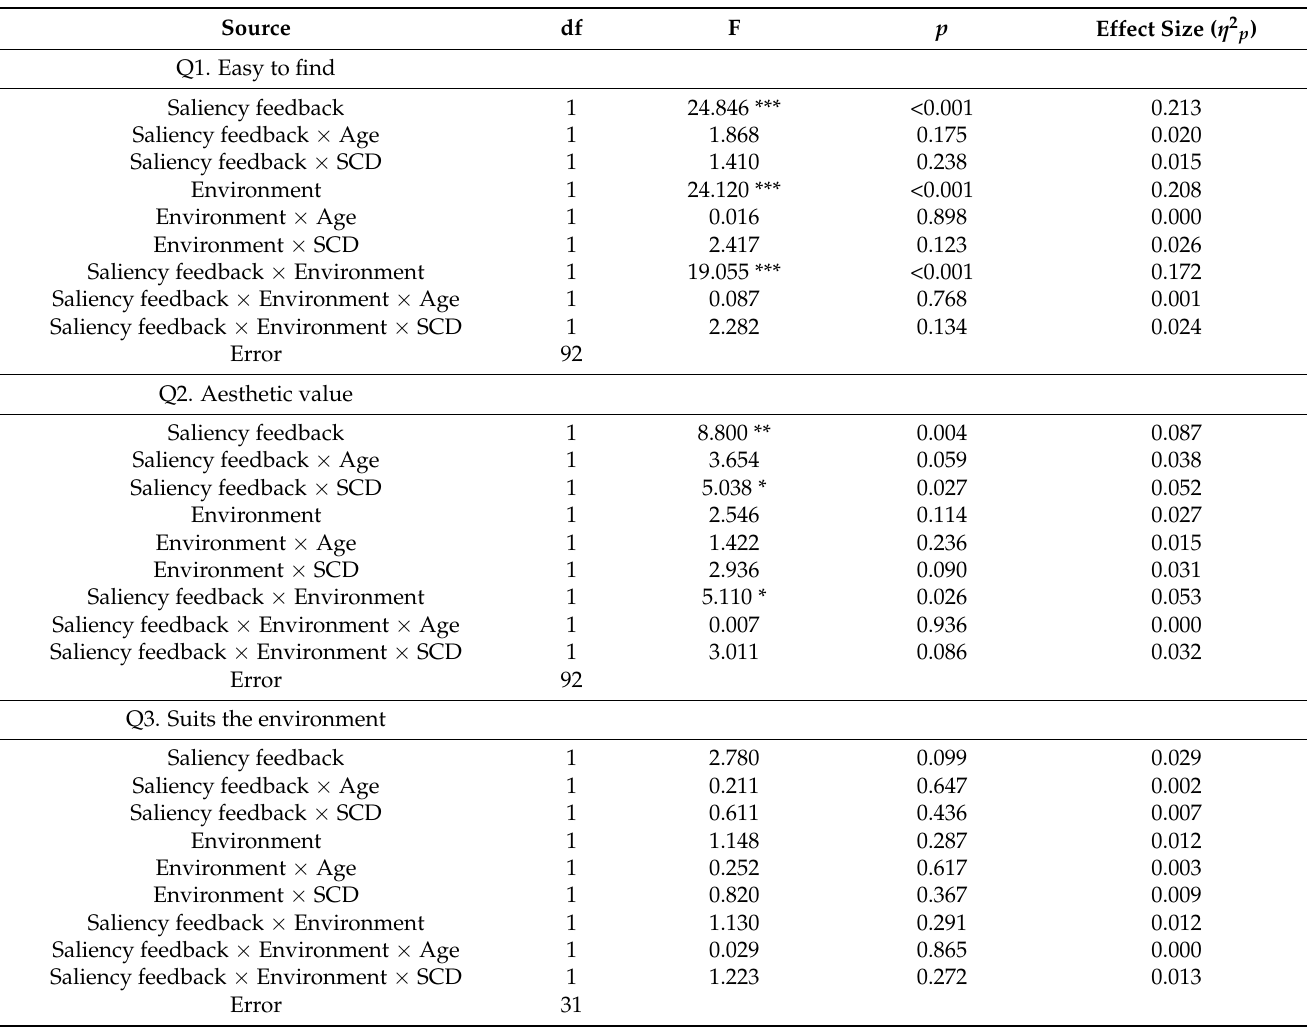
Table A4. Main and interaction effects of the provision of saliency feedback during the design process, the environment, the participant age, and SCD on end-user ratings (design quality evaluation) for the sign design outcome that was produced in the user study (multi-way mixed